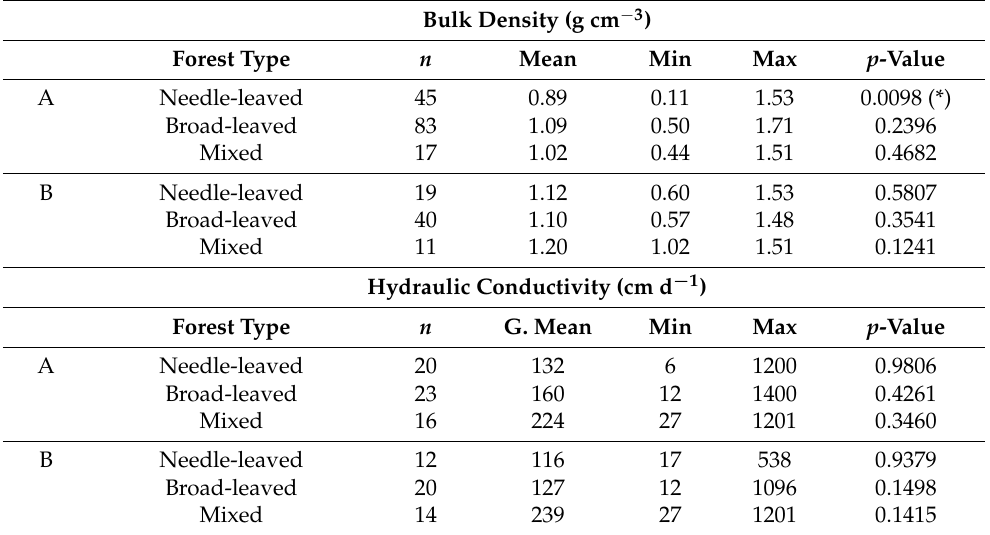
Figure 2. Descriptive statistics of top mineral soil bulk density by forest type considering the two data sets: dataset A containing all values found and dataset B filtered values based on available information on tree age and the soil particle size. All values refer to the topsoil (0–30 cm depth). Black dots represent the outliers. Table 3. Summary of statistics for soil bulk density and saturated hydraulic conductivity sorted according to forest type. Dataset A contains all results found in the screened articles; dataset B considers only those values reported with additional information on soil particle size and tree age. All values refer to the topsoil (0–30 cm depth). G Mean refers to the geometric mean. (*) indicates the group of forest with significantly different BD